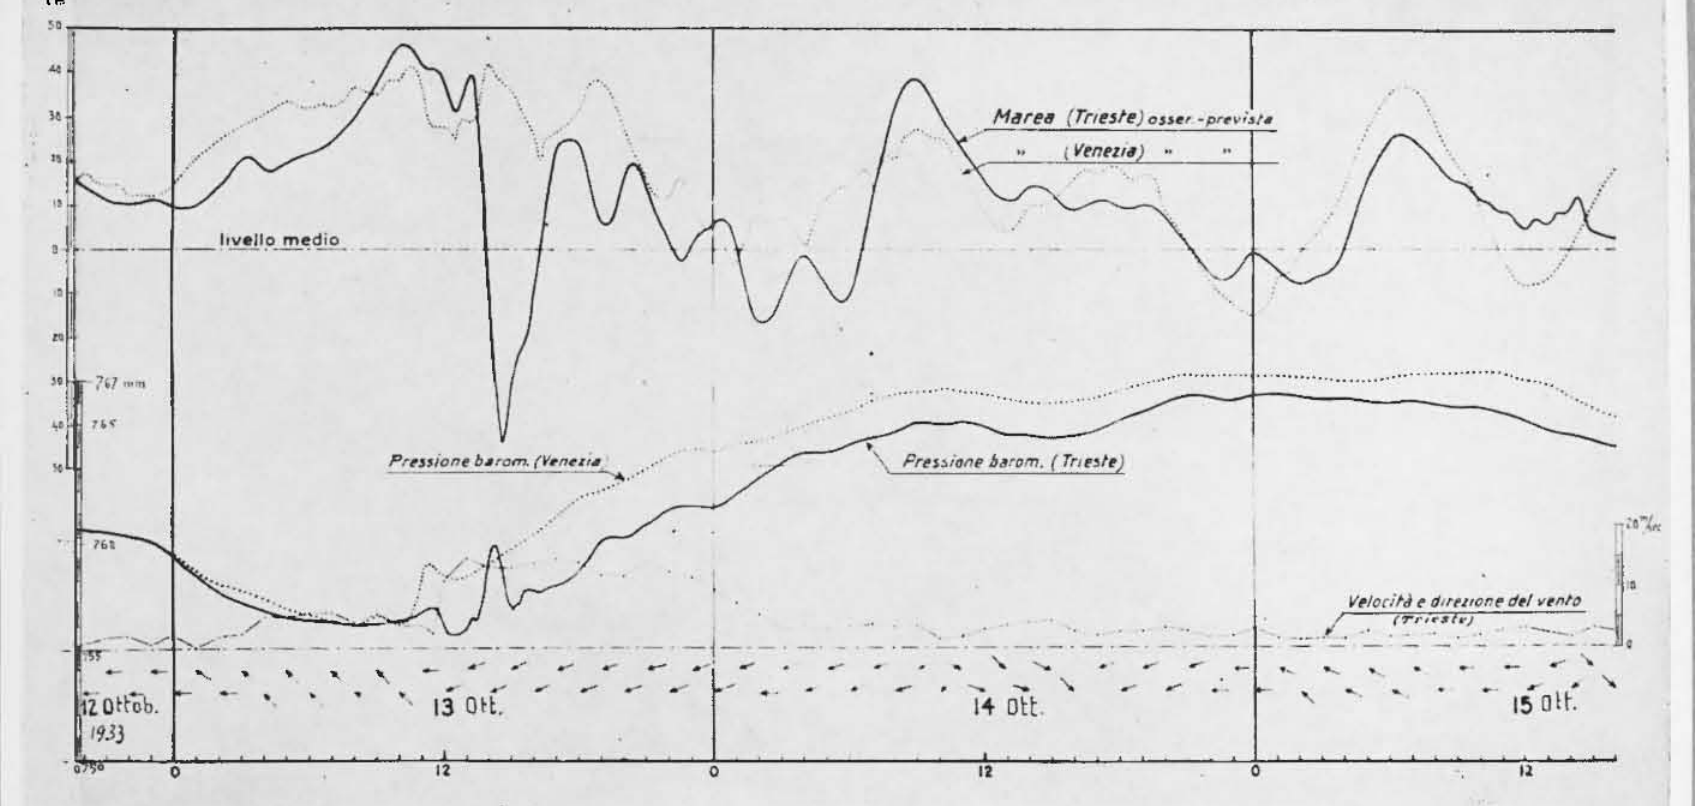
Fig. 4 - In questo CUSO, ]'inf.crazione fra atmosferu eù idrosfera si è manifestata sui lunghi periodi, destanùo le sesse del golfo di Venezia (trasversali) e quella uninodule dell'intero Adriatico e dell'alto c medio Adriatico. J,'inizialc nucleo positivo della pressione, dell'ordine di 3 Ton, ha provocato un abbassamento ùcllivello ùel mare a Trieste pari a 83 Cill, con un effetto dinamico piìt di 20 vo\t.e qudl0 statico. Fig. 4 - In this case t,he intcl'uction betwecn atmosphcre and hydrosphcl'c beeume appal'cnt on thc long pcriods by arousing: thc seichcs of thc Gulf of Venice (tl'unsvcl'sal) anù the uninodal osdllation of the entire Adriatic Sea anù of t,he high anù medium sectors of it. The initial positive pressure nucleus in t,he orùer of 3 Torr brought about a reduetion of t,he sea level at Trieste of about 83 cms, with a ùynamie effect, of over 20 times as strong as the static one.